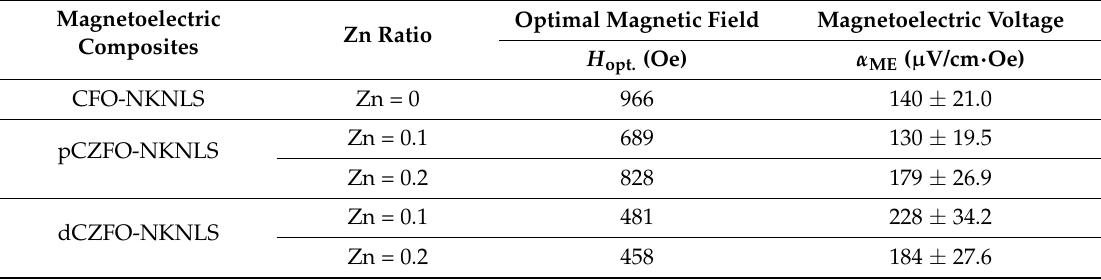
Figure 5. ME voltage of particulate composites consisting of a piezoelectric phase of NKNLS and magnetostrictive phases of ( a ) CFO and pCZFO (Zn = 0.1, 0.2) and ( b ) CFO and dCZFO (Zn = 0.1, 0.2). Table 2. Magnetoelectric (ME) responses of CFO-NKNLS, pCZFO-NKNLS, and dCZFO-NKNLS composites; optimal magnetic field ( H opt. ) and ME voltage ( α ME